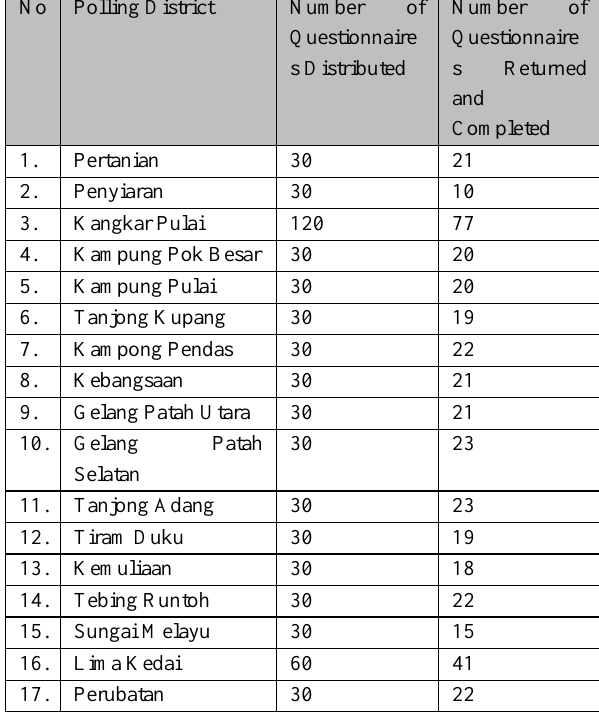
Table 1. The number of completed